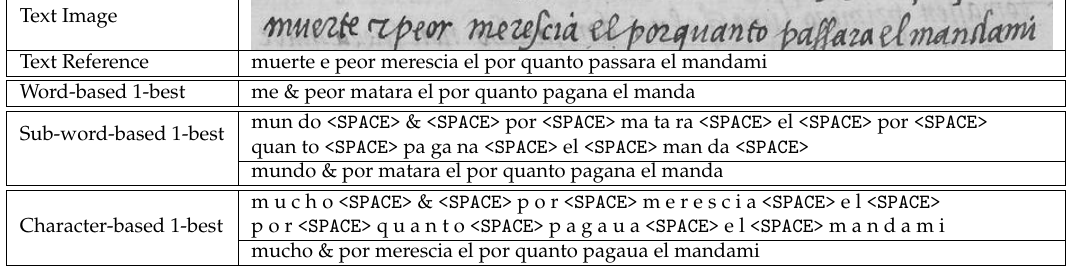
Figure A1. Example of the best hypotheses obtained for the 12th line of page 500 of Rodrigo .